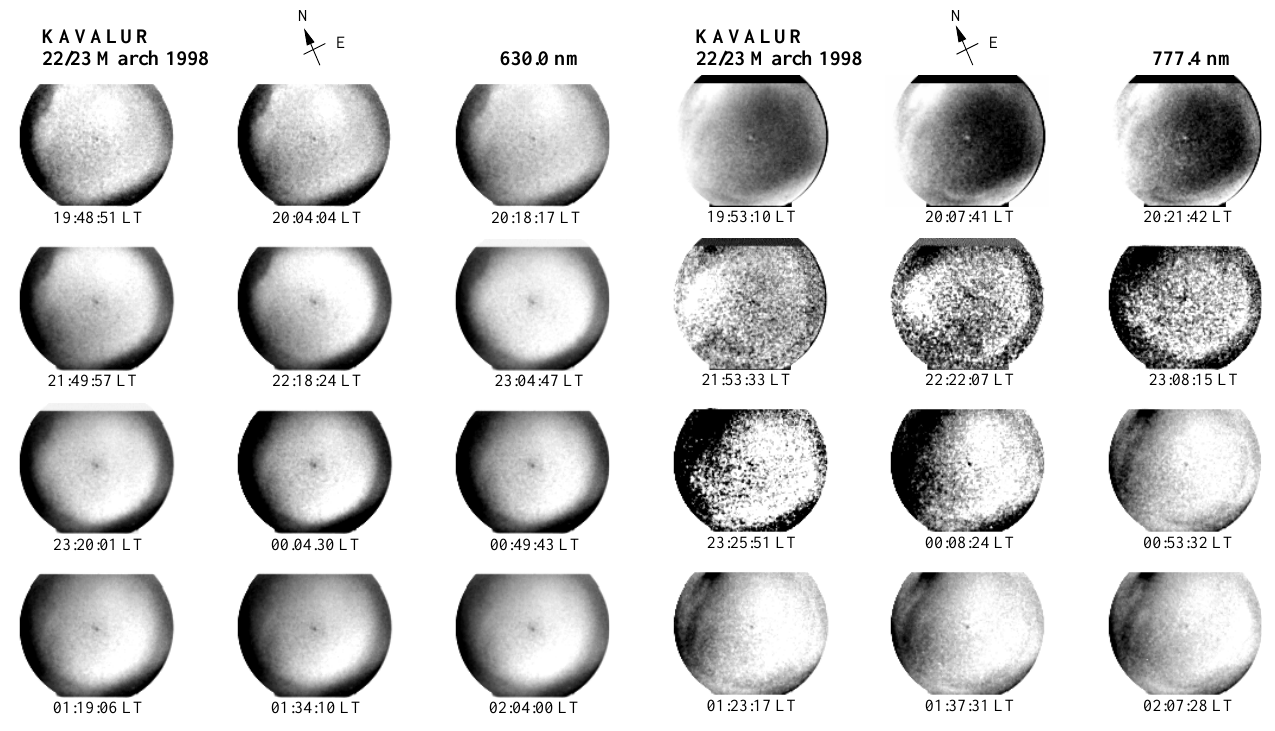
Fig. 11. Plasma enhancements or brightness patterns in the 630nm images taken over Kavalur on the night of 22/23 March 1998. The arrow points towards the geomagnetic north.